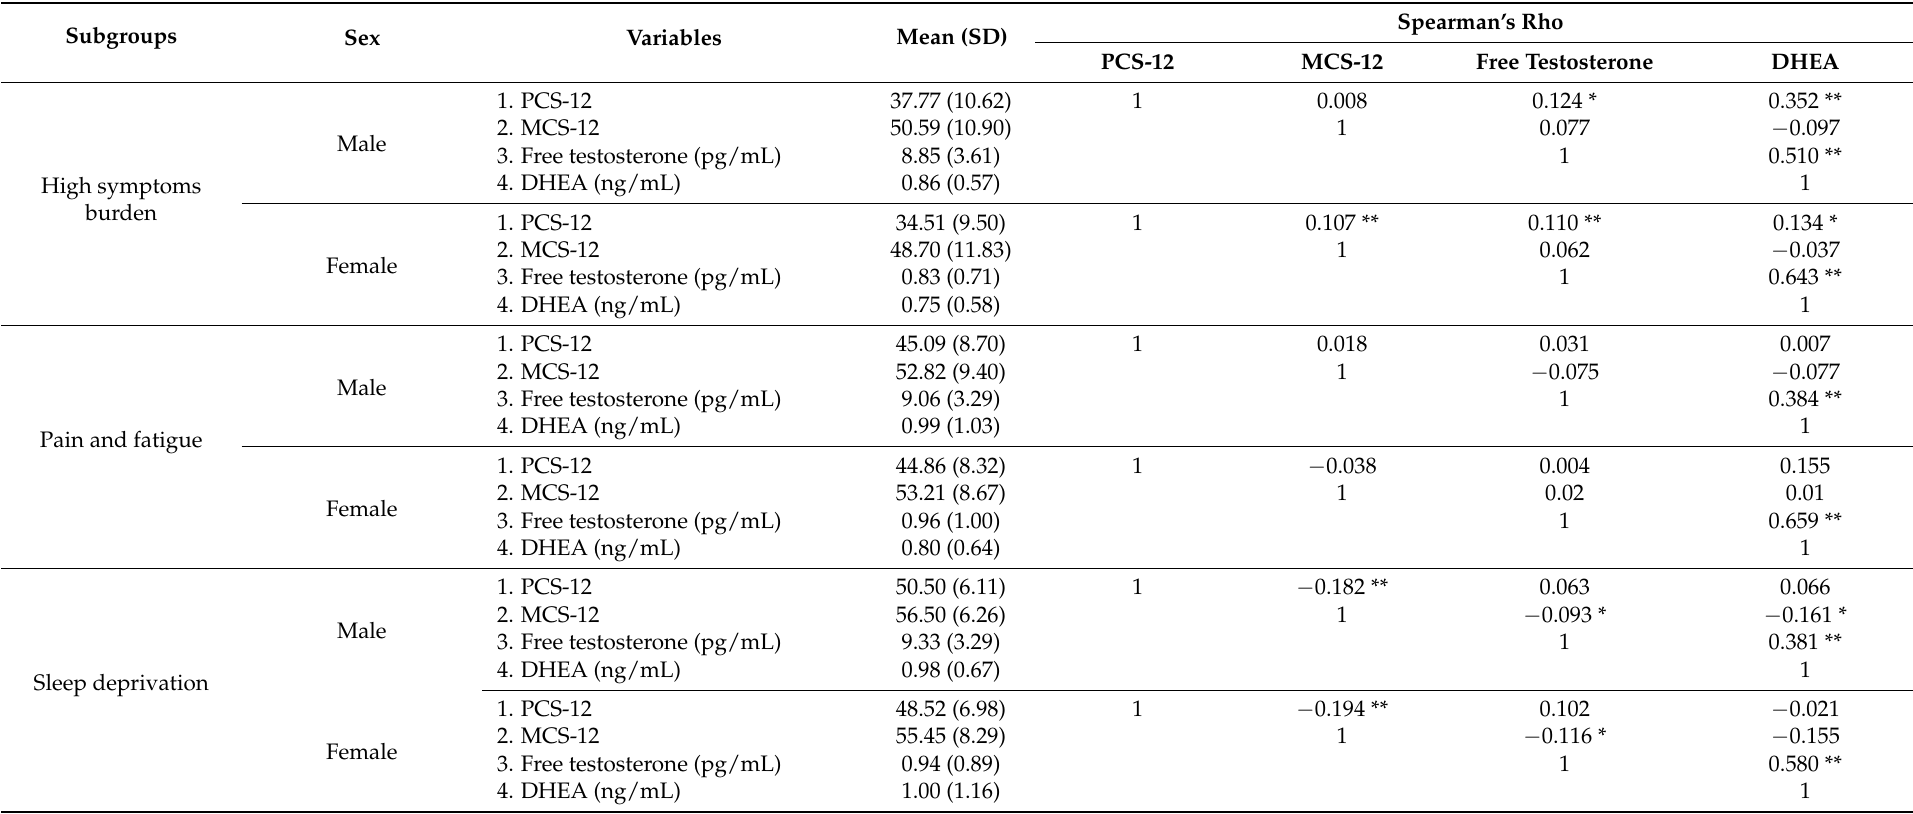
Table 5. Associations of symptoms clusters, health-related quality of life, and sex-specific clinical blood markers. Spearman’s Rho Subgroups Sex Variables Mean (SD) PCS-12 Free Testosterone DHEA